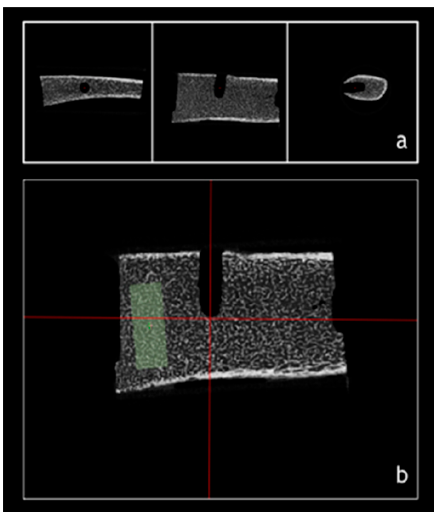
Figure 1. Determination of volume of interest (VOI). ( a ) From right to left: Axial, coronal, and sagittal cuts of microcomputed tomography (µCT) images. ( b ) Using reference lines, perforation midcenter was determined. and VOI was segmented.